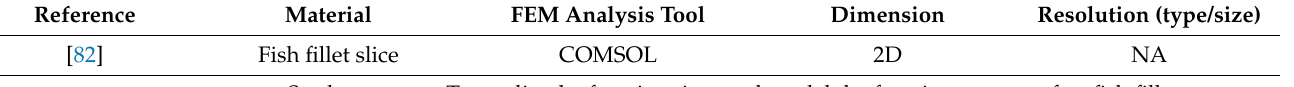
Table 1. Examples of finite element method application in food freezing. FEM: Finite element model.